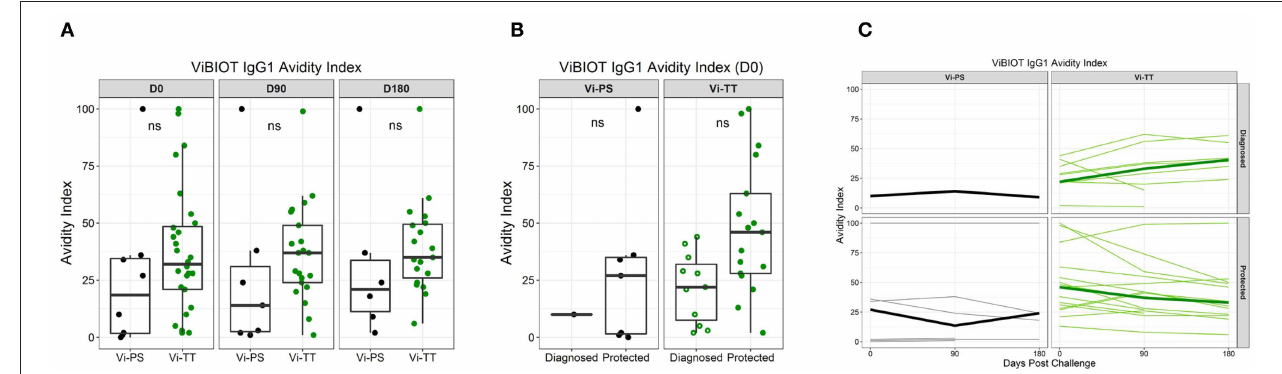
FIGURE 5 | Vi polysaccharide IgG1 avidity higher in protected individuals. ViBIOT IgG1 avidity index at pH 3.0 in positive vaccine responders by vaccine group over time (A) and by diagnosed/protected outcome at day of challenge (B) . Avidity index in positive vaccine responses of anti-ViBIOT IgG1 over time (C) from 4 weeks post-vaccination (D0) to 6 months post-challenge (D180) by vaccine group and protection status. Bolded lines indicate median avidity index and faint lines indicate individual level data. Data points are representative of n = 2 independent experiments (each with n = 2 technical replicates). nt indicates not tested for statistical significance.